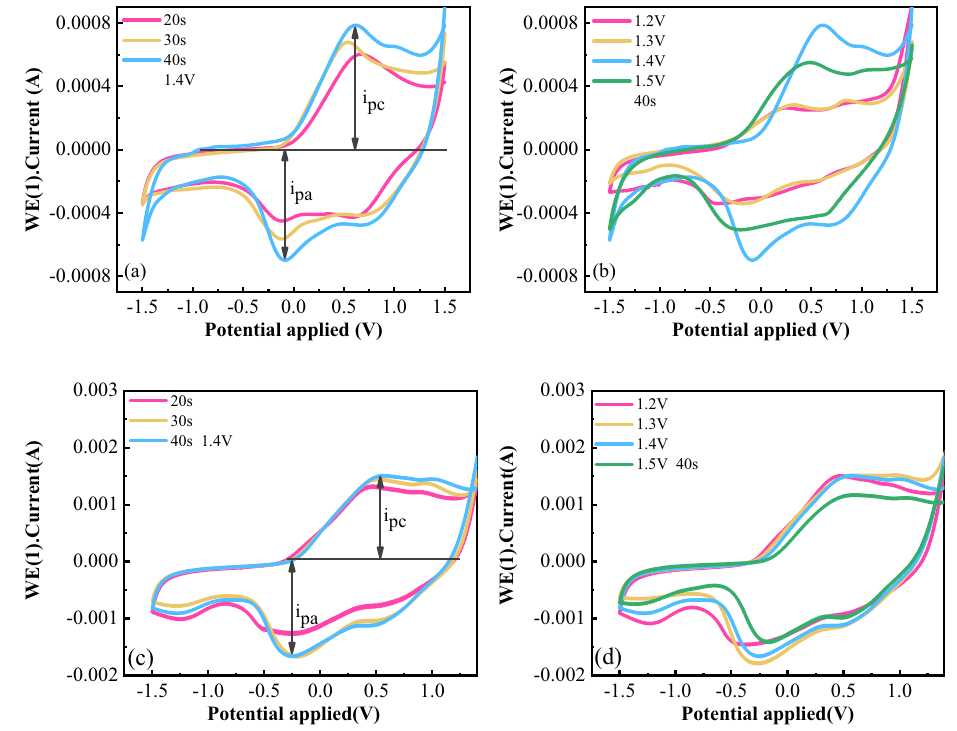
Figure 4: Cyclic voltammetry curve of ( a ) PEDOT:PSS deposited at 1.4 V for di ff erent times, ( b ) PEDOT:PSS deposited at di ff erent voltages for 40 s, ( c ) PEDOT:PSS/EMI - TFSI deposited at 1.4 V for di ff erent times, and ( d ) PEDOT:PSS/EMI - TFSI deposited at di ff erent voltages for 40